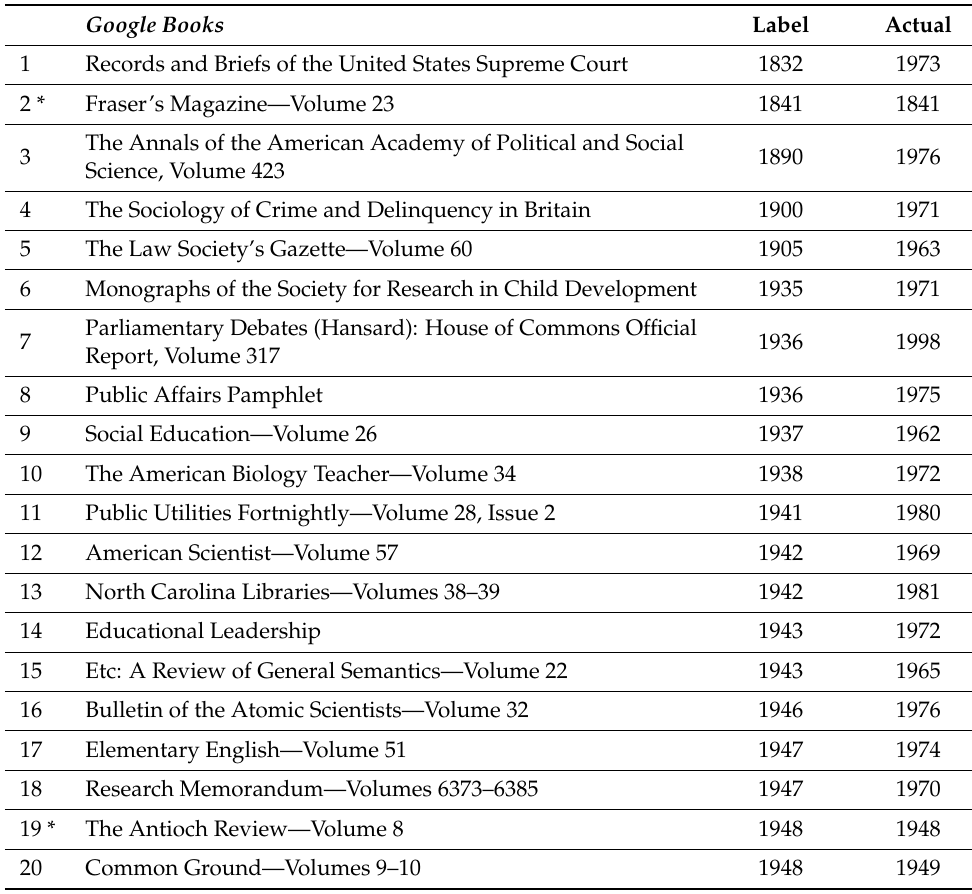
Table 1. Search results obtained by repeating the method presented in Sutton and Griffiths